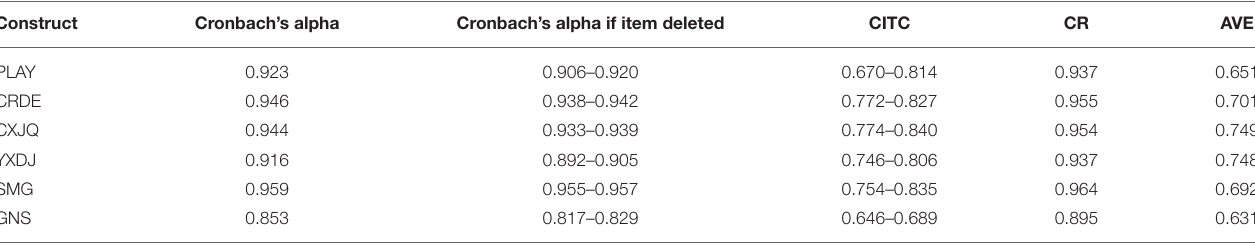
TABLE 6 | Test results of reliability and convergent validity.